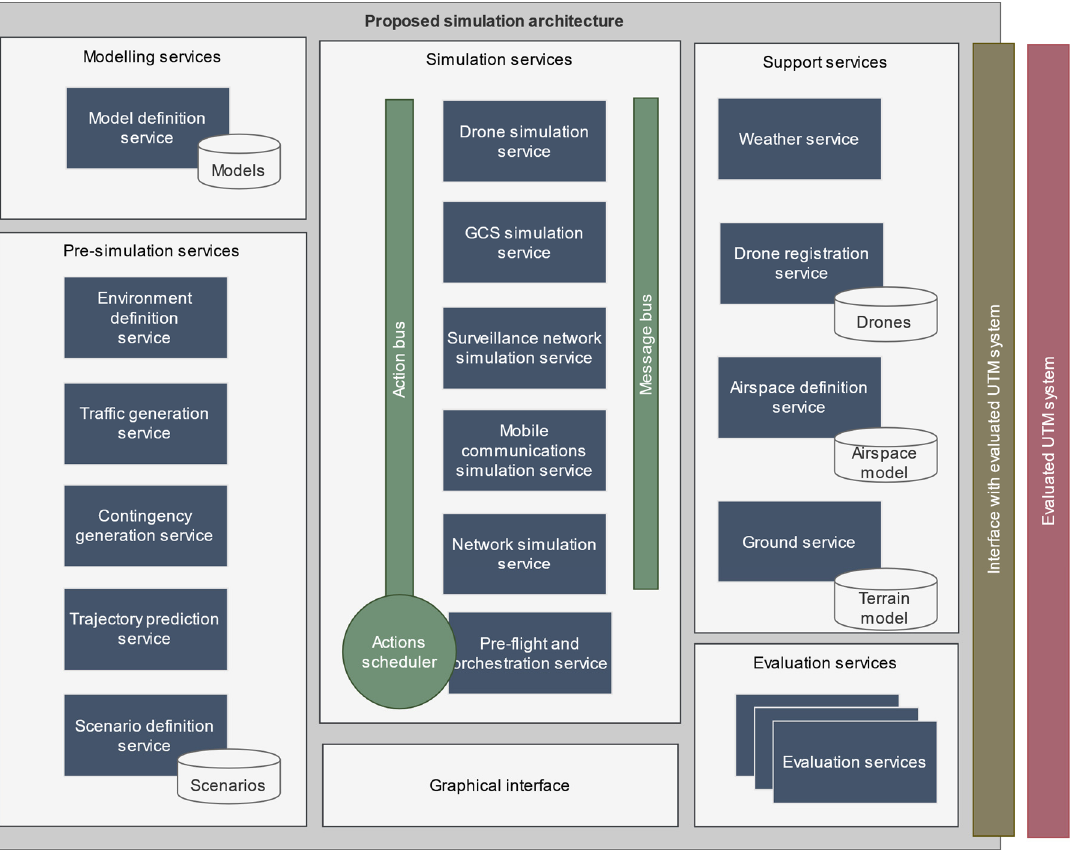
Figure 2. Detail of the microservice-based, extendable simulation architecture proposed in [3]. Extracted from [3],.with permission.